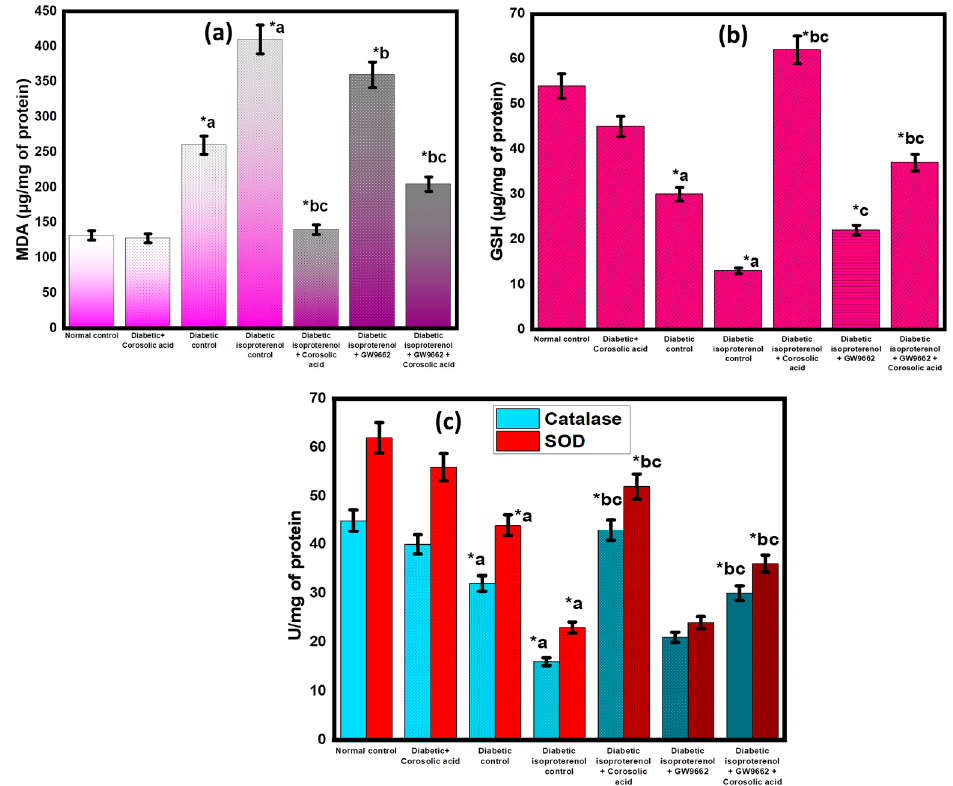
Figure 5. The effect of corosolic acid on oxidative stress in different groups: ( a ) MDA content; ( b ) GSH; ( c ) catalase and SOD. The data are expressed as mean ± SEM. * p ≤ 0.05 is considered significant. a normal control vs. diabetic control and diabetic isoproterenol control; b diabetic control vs. corosolic acid and GW9662 treatments; and c diabetic isoproterenol control vs. corosolic acid and GW9662 treatments.